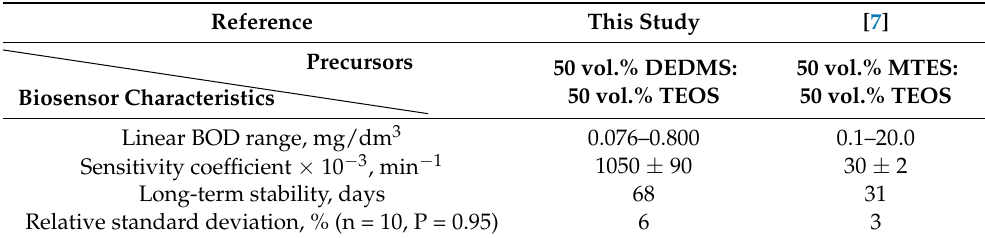
Table 1. Comparison of the main analytical parameters of bacterial biosensors based on Paracoccus yeei with various types of precursors in an immobilization